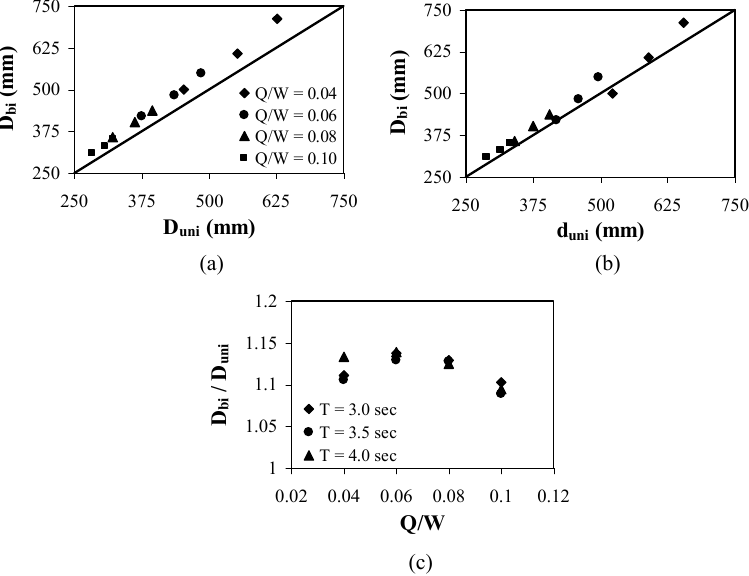
Fig. 5. Comparison of D bi and D uni obtained from NRHA with d bi and d uni calculated as per ASCE (2005) regarding ground motions in Bin1.